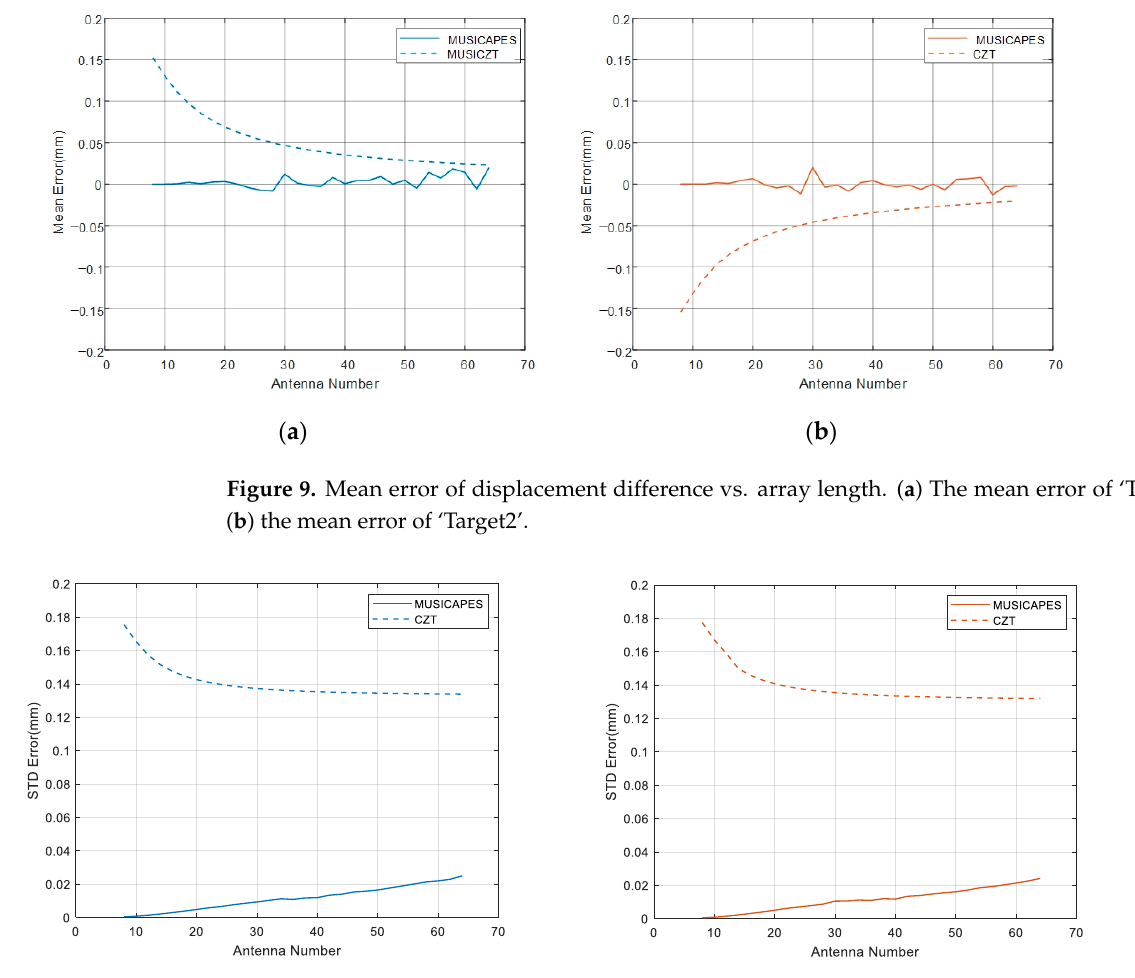
( b ) Figure 8. STD of displacement difference vs. angle interval. ( a ) STD of ‘Target1’; ( b ) STD of ‘Target2’. 4.1.3. Measurement Performance of Two Targets vs. Array Length We will test the displacement estimation performance versus the number of anten- nas. In this simulation case, the number of transmitting antennas is set to be 1; the number of receiving antennas varies from 8 to 64 with an incremental step of 2. There are also two targets. ‘Target1’ is still fixed at (20 m, 0°). ‘Target2’ is on the right side, 20 m from the radar. The angle interval between the two targets is equal to half the angular resolution of the used array. It is known that the angular resolution is inversely proportional to the number of antenna arrays. As a result, the larger the number of antennas, the smaller the angle interval. Figure 9 shows the means of the displacement measuring errors of the two targets.